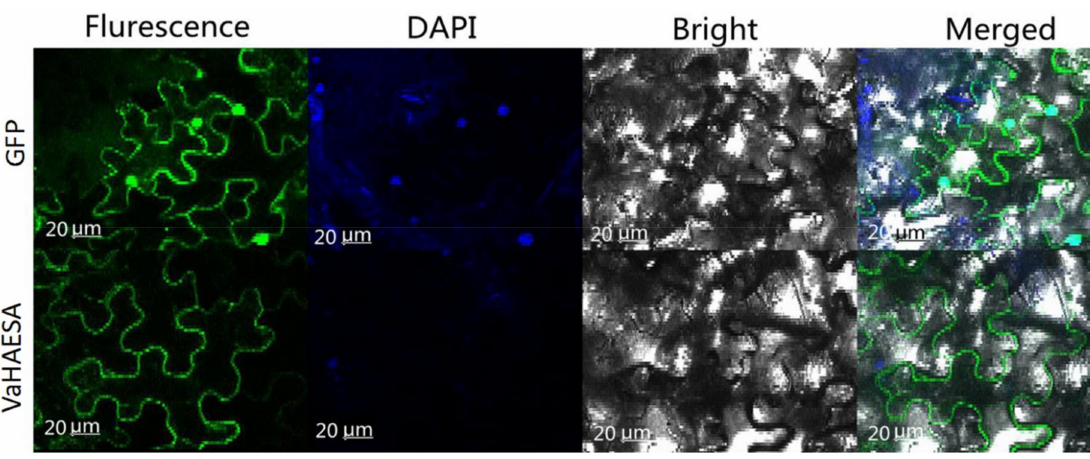
Figure 6. Subcellular localization of the GFP - VaHAESA protein in transiently transformed Nicotiana benthamiana .